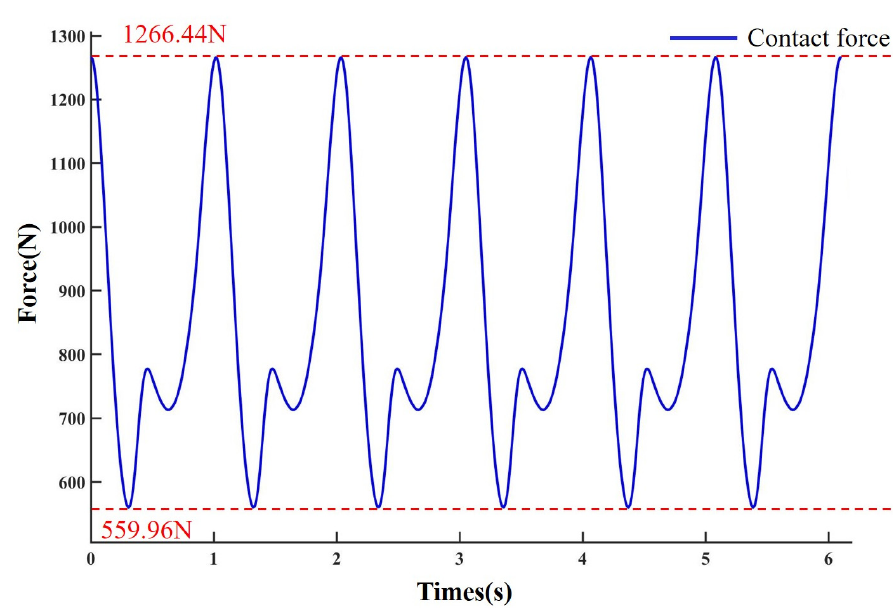
Figure 6. Curve of contact force.